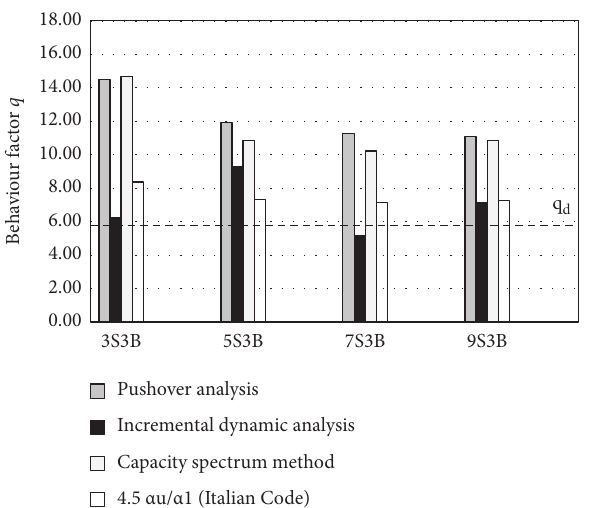
Figure 12: Comparison of behaviour factors obtained with different methods.